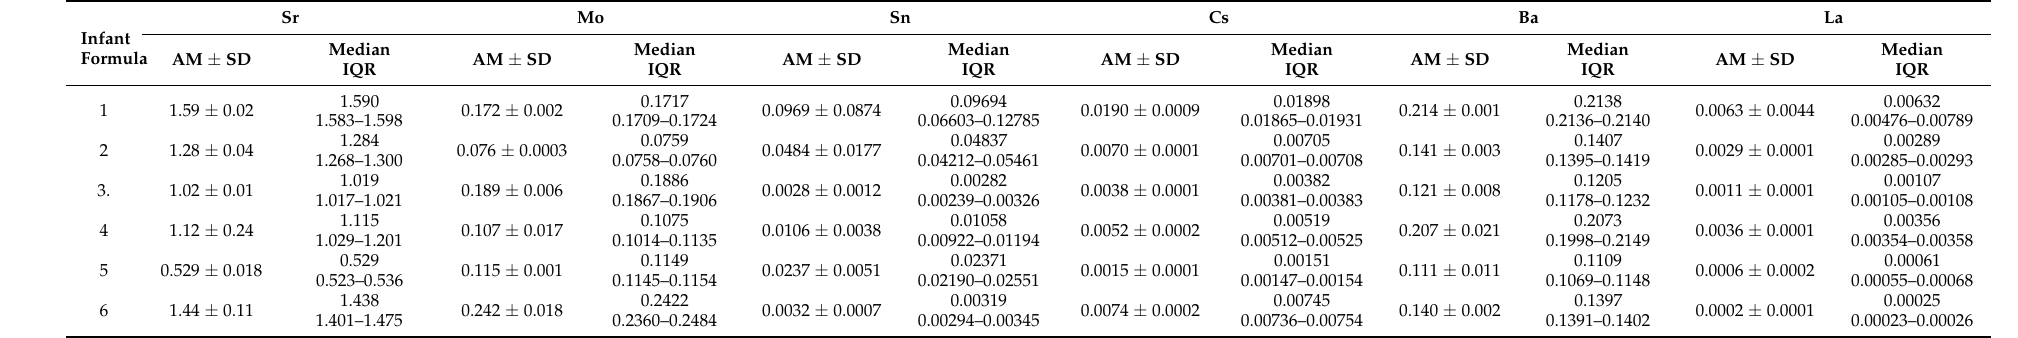
Table 4. Descriptive statistics of Sr, Mo, Sn, Cs, Ba and La calculated on a total of 12 determinations for each formula and expressed as µ g g − 1